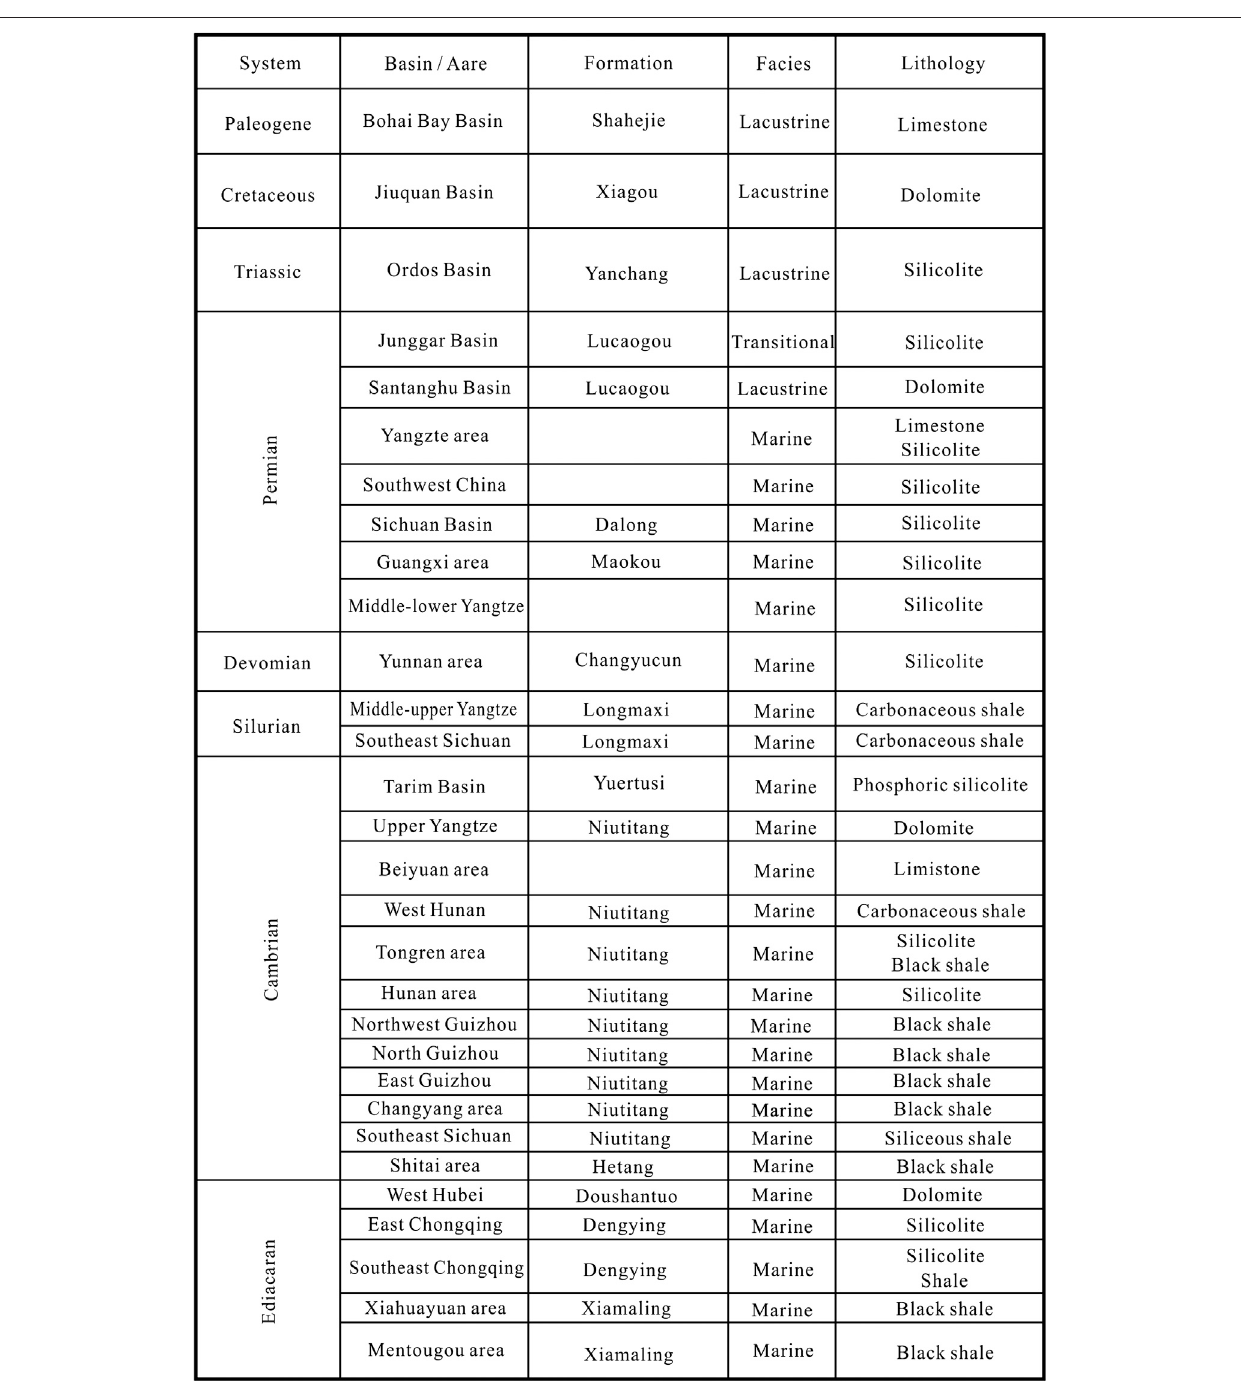
FIGURE 1 | Stratigraphic distribution of source rocks related to hydrothermal activity in China (modi fi ed after Jia et al., 2016).